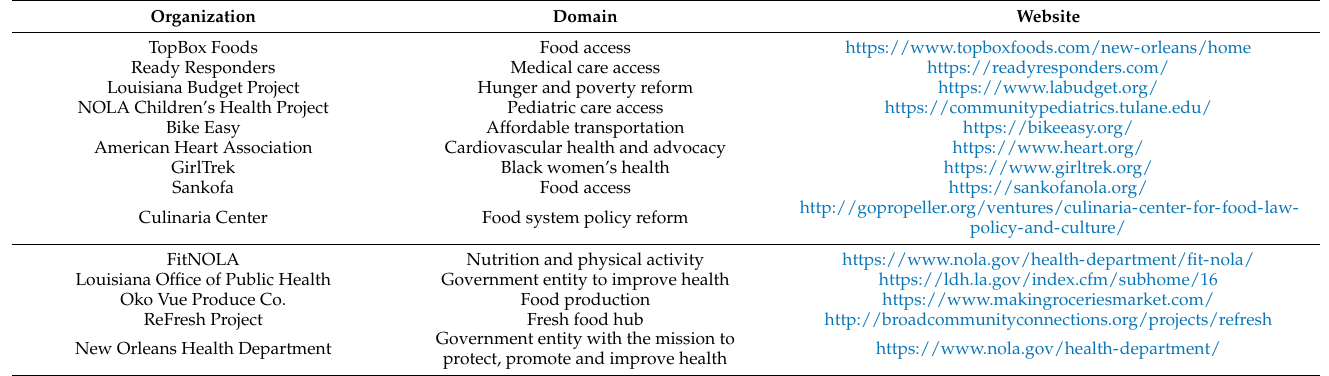
Table 1. Community Organizations in Attendance at the Community